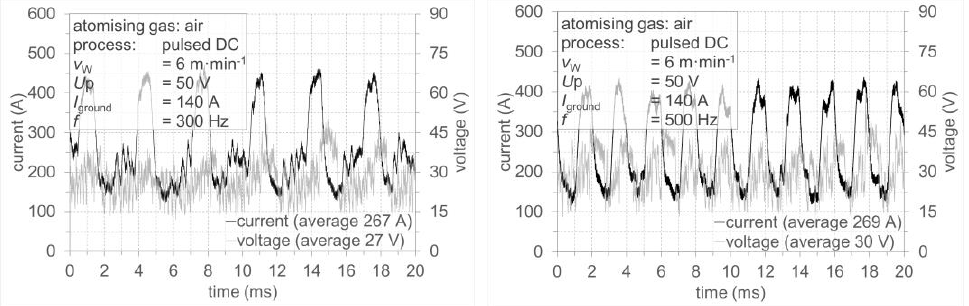
Figure 14. Current/voltage curve, pulsed direct current, ( left ) : f = 300 Hz, ( right ) : f = 500 Hz.